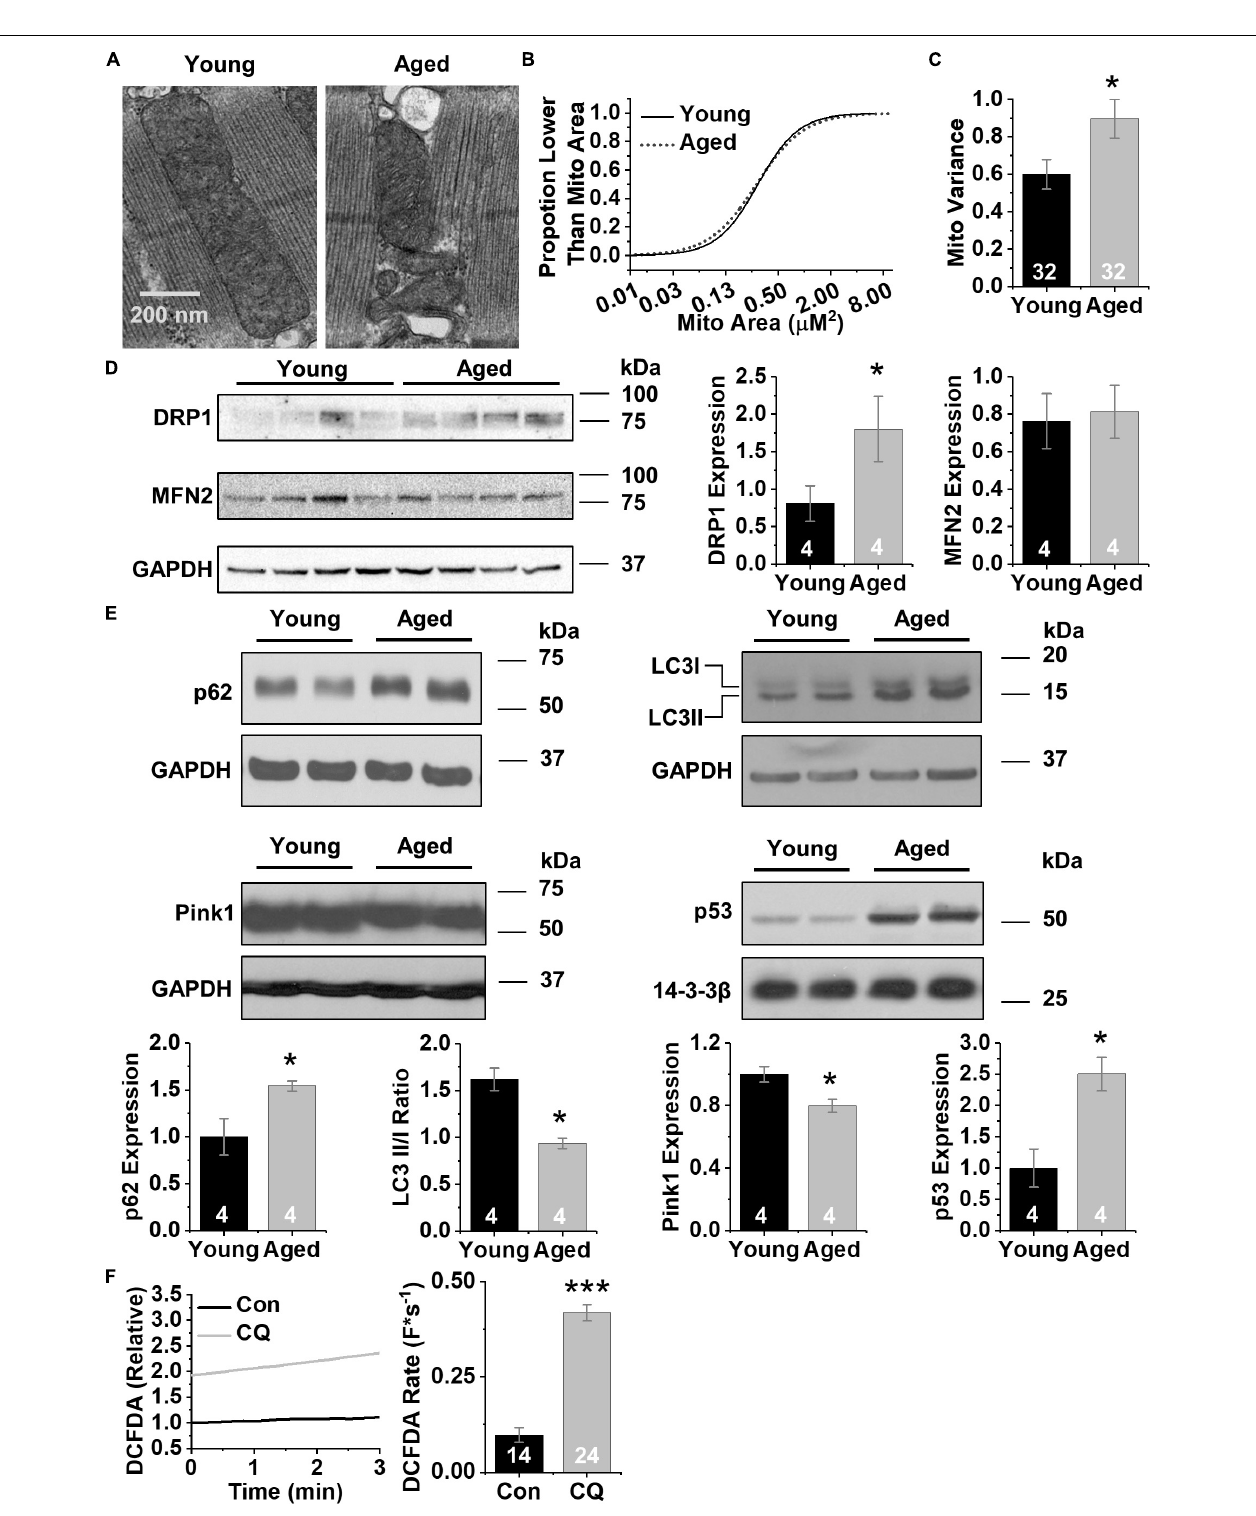
FIGURE 1 | CM aging leads to heterogeneous mitochondria and decreased markers of autophagy. (A) Representative transmission electron micrographs of acutely disassociated CMs from young and aged rabbit hearts, scale bar = 200 nm. (B) Cumulative distribution of mitochondrial log 2 cross-sectional areas assessed by image analysis of electron micrographs in young and aged CMs. Analysis of data was performed using the GLIMMIX procedure in SAS Version 9.4 (SAS Inc.) ( ∗ p < 0.05). (C) Variance in mitochondrial cross-sectional areas. (D) Representative immunoblots for mitochondrial fission and fusion proteins, DRP1 and MFN2